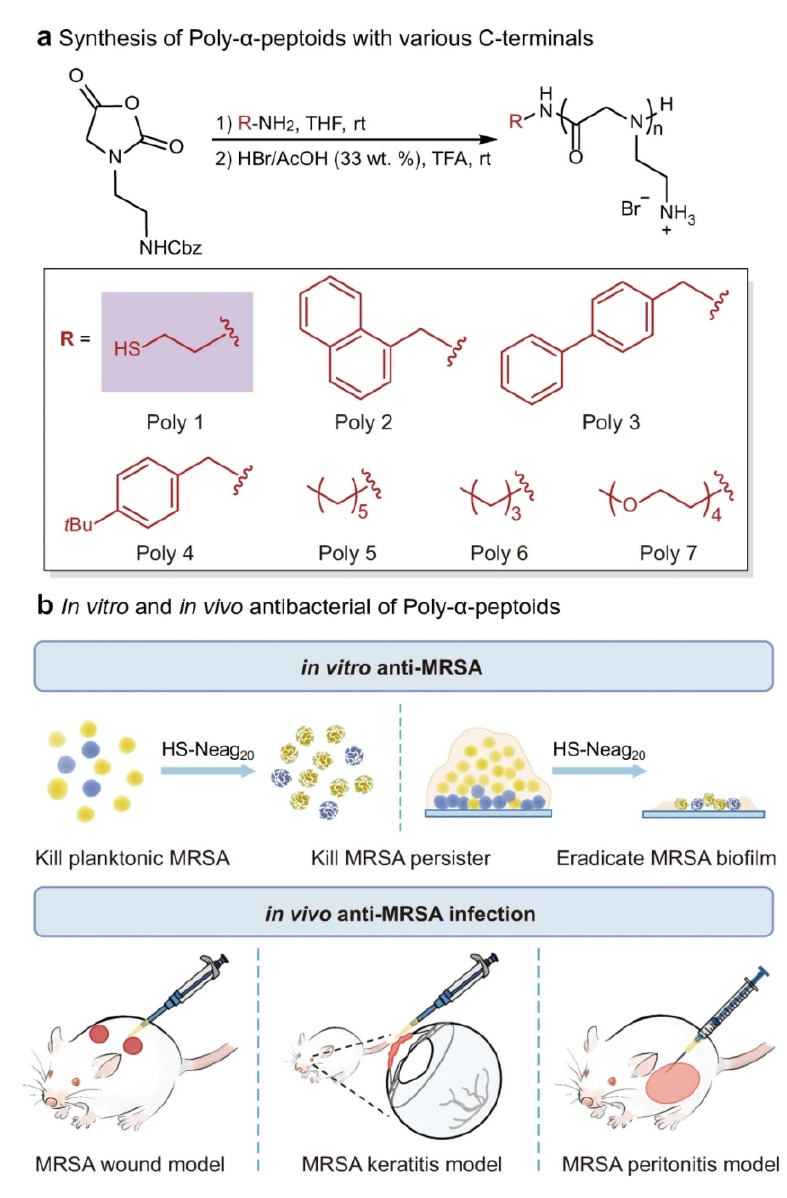
Figure 8. Design and synthesis of peptoid polymers with anti-MRSA activity. ( a ) Synthesis of poly- α -peptoids bearing variable C-terminal functional groups. ( b ) Schematic illustration on the antibacterial performance of poly-Naeg, in vitro and in vivo (Adapted from ref. [74]. Copyright 2021, The authors).